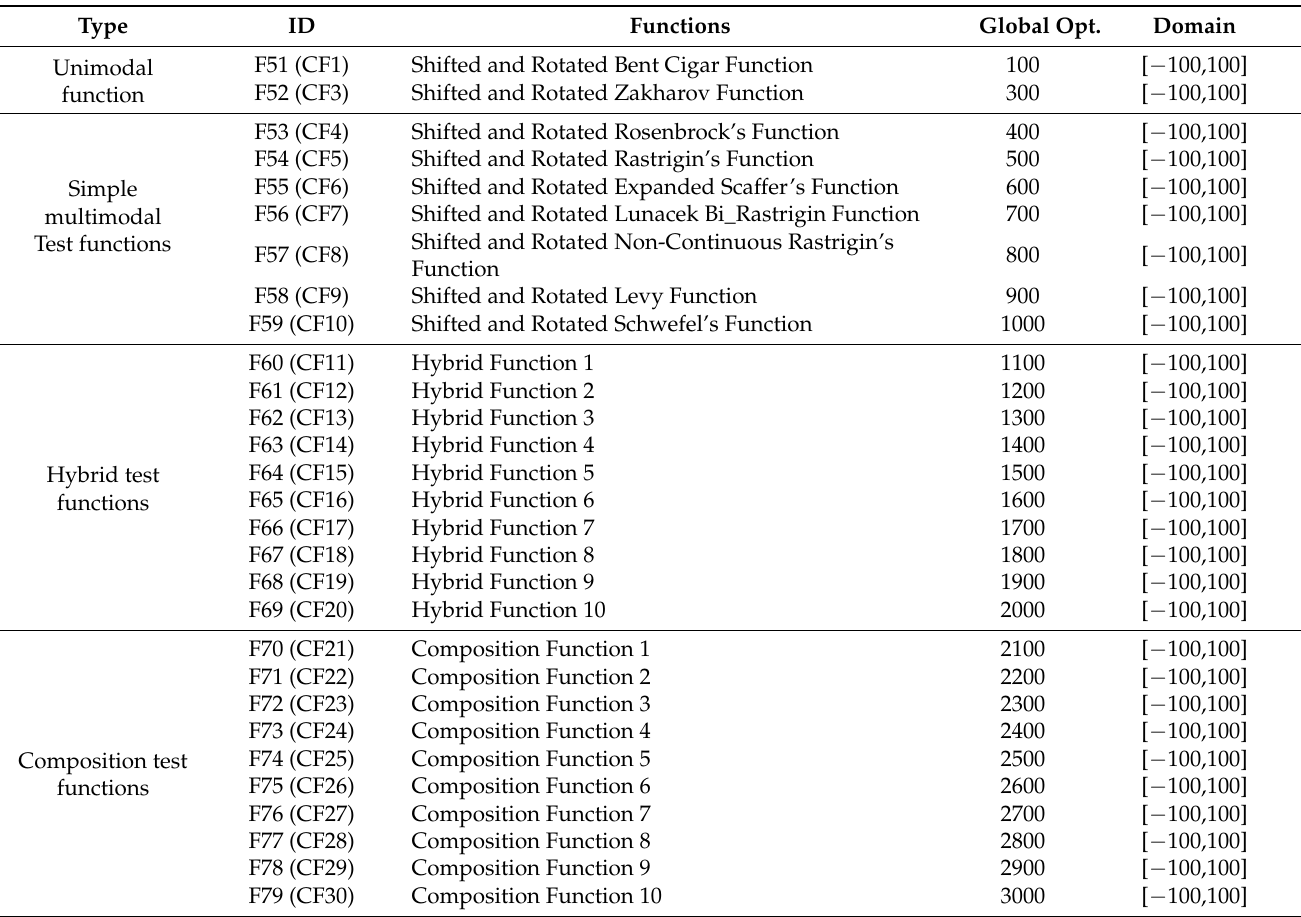
Table A5. Description of CEC-2017 benchmark.